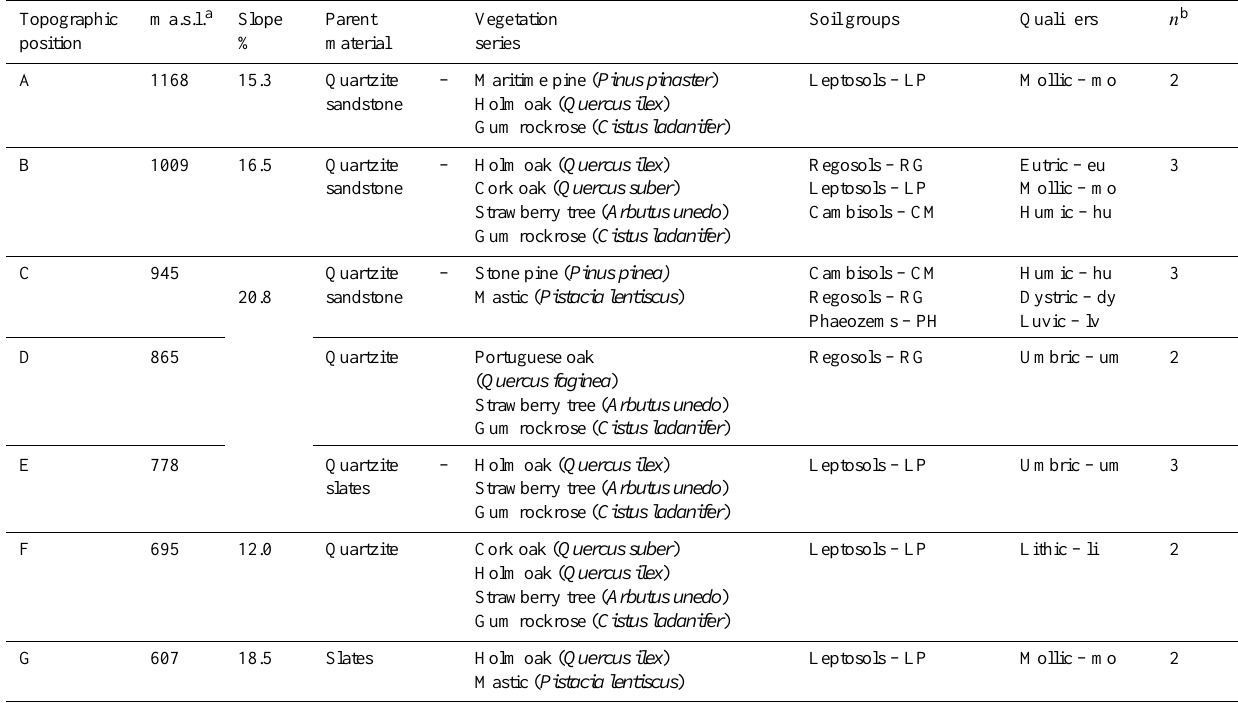
Table 1. Soil groups of the study area at each of the seven topographic positions with properties. The key refers to the reference soil groups of the IUSS Working Group WRB (2006) with lists of qualifiers.